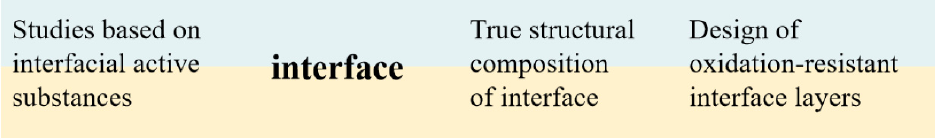
Figure 3. Research prospects for interface applications.